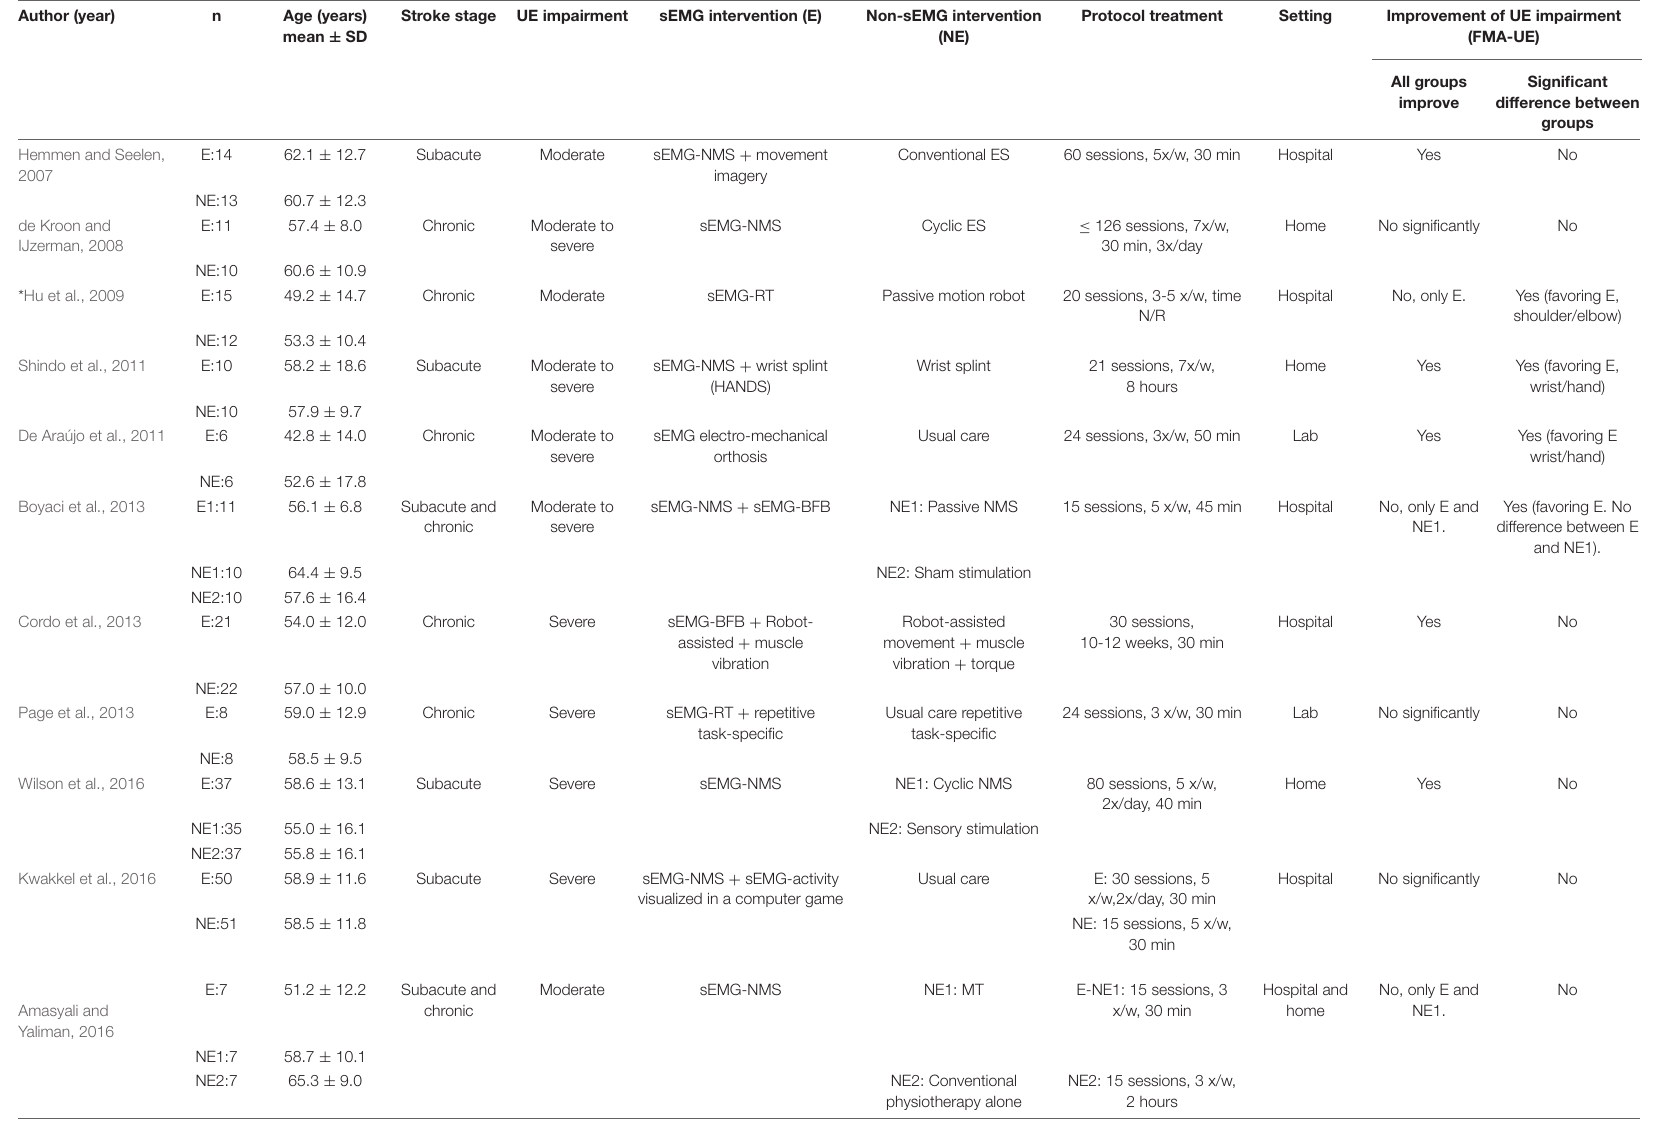
Protocol treatment Setting Improvement of UE impairment (NE)